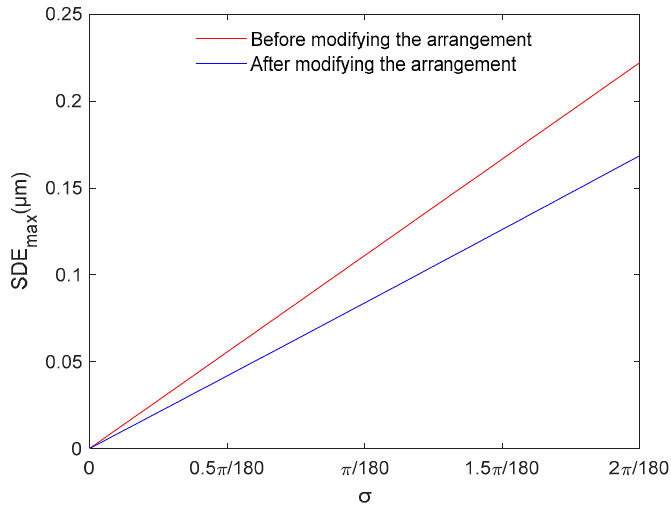
Figure 6. Maximum subdivision error within one signal period (SDE) caused by linear errors.